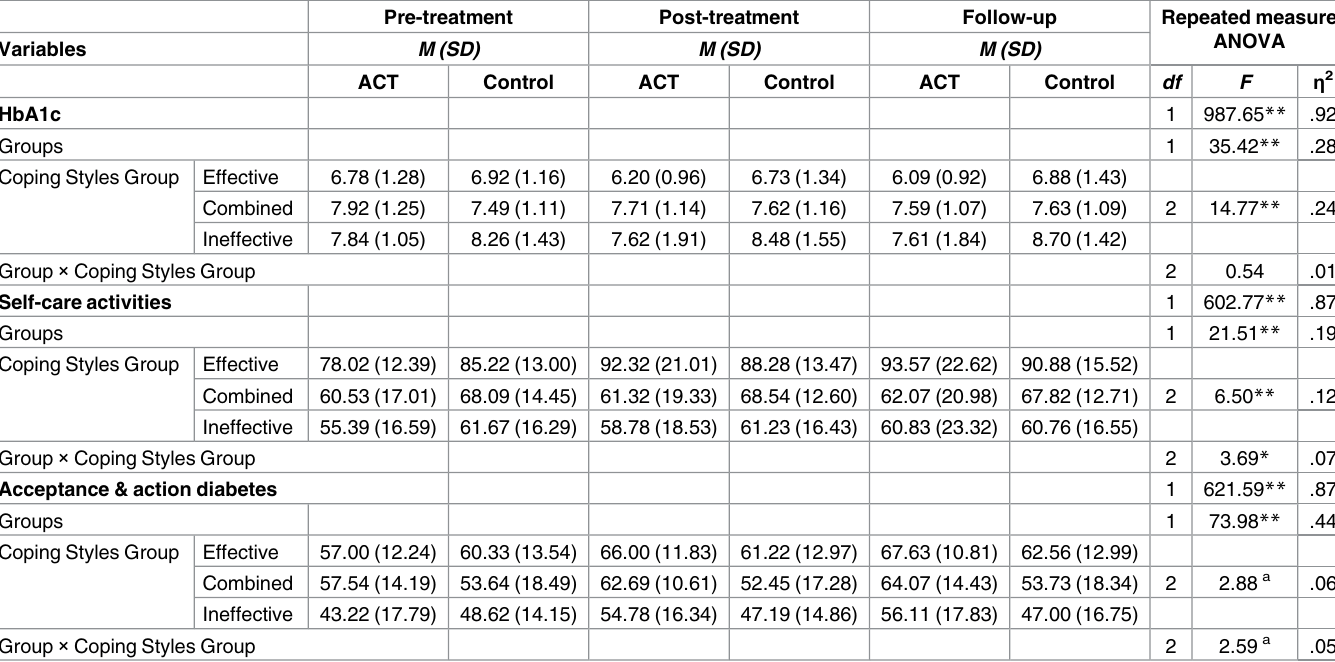
Table 3. Results of Repeated Measure ANOVA for coping styles as a moderator between the ACT and HbA1c, self-care and